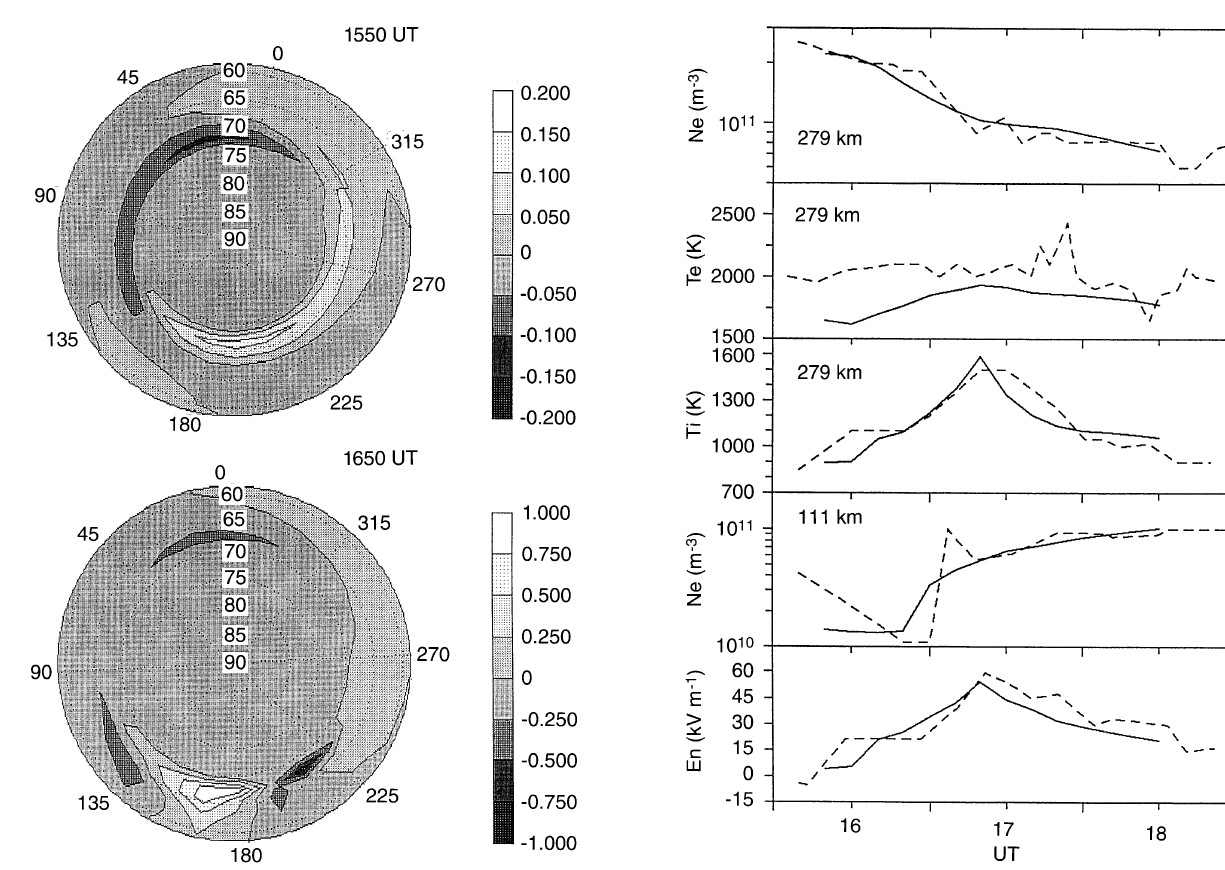
Fig. 3. The geomagnetic ( (cid:85) , (cid:75) ) polar plots of the calculated field- aligned current density (A km (cid:126)(cid:50) ) in the northern high-latitude iono- sphere at the growth phase ( top ) and at the expansion phase ( bottom ) of the substorm; the Sun position is at the top of the figure